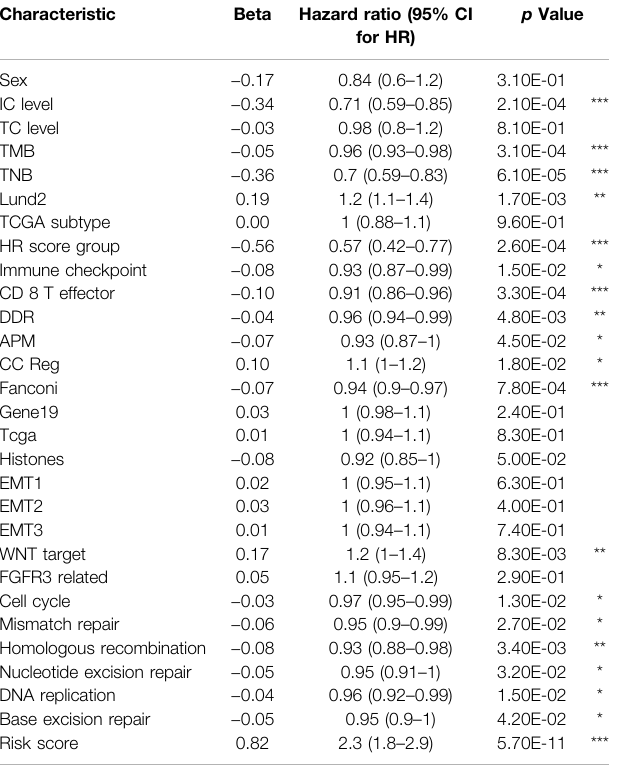
TABLE 3 | Univariate Cox regression analysis.